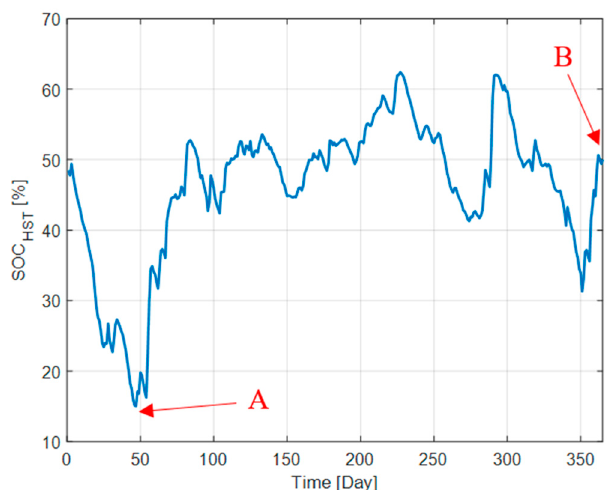
Figure 3. Simulated year-through solid oxide cell (SOC) HST trajectory. A and B labels highlight minimum and final hydrogen tank levels, respectively, which are used later on in the paper to assess the potential self-sufficiency range achieved by the optimal renewable rSOC-based microgrid design. Table 3. Constrained optimization (see Section 3.2) outcomes in terms of costs (€) and nominal microgrid component power/size.